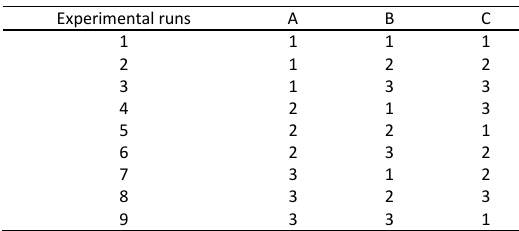
Table 3: Taguchi orthogonal arrays (L 9 )